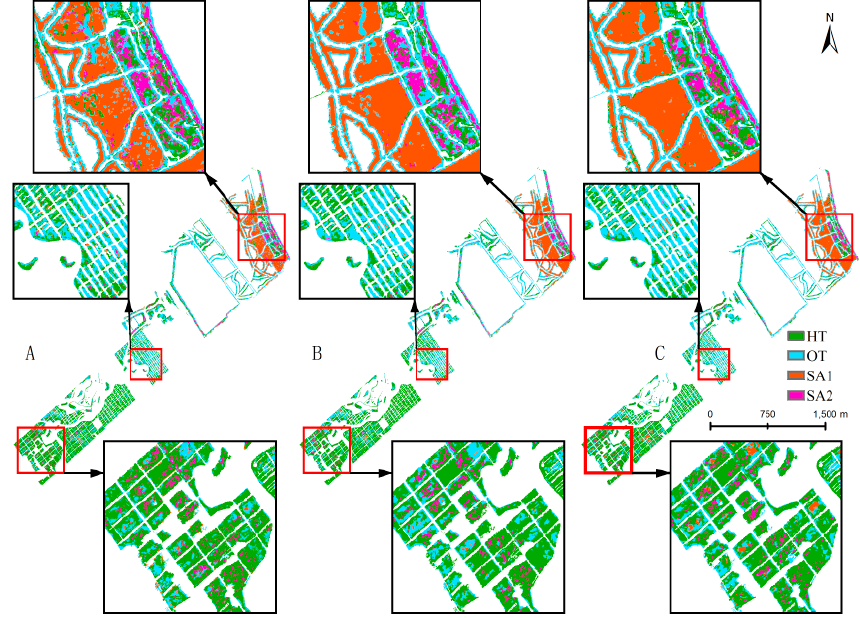
Figure 4. Comparison of pixel-based classification: ( A ) decision tree-based classification; ( B ) support vector machine based classification; and ( C ) random forest-based classification.